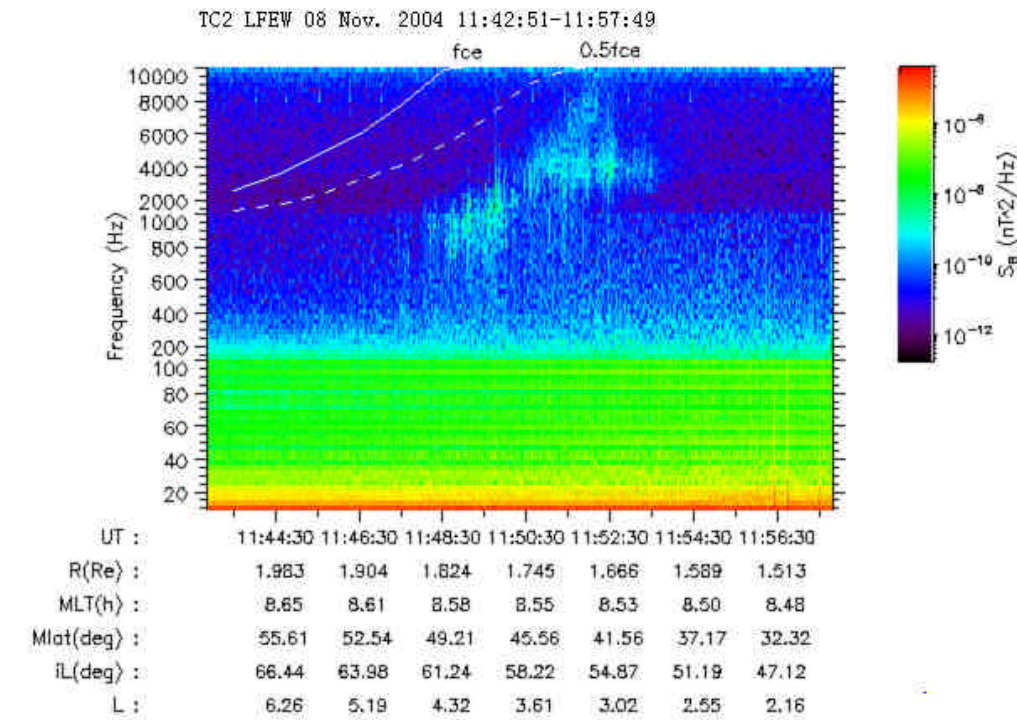
Fig. 8. Plasmaspheric hiss and mid-latitude hiss in the Northern Hemisphere observed by LFEW on 8 November Fig. 8 Plasmaspheric hiss and mid-latitude hiss in the northern hemisphere observed by LFEW on Nov.08, 2004.